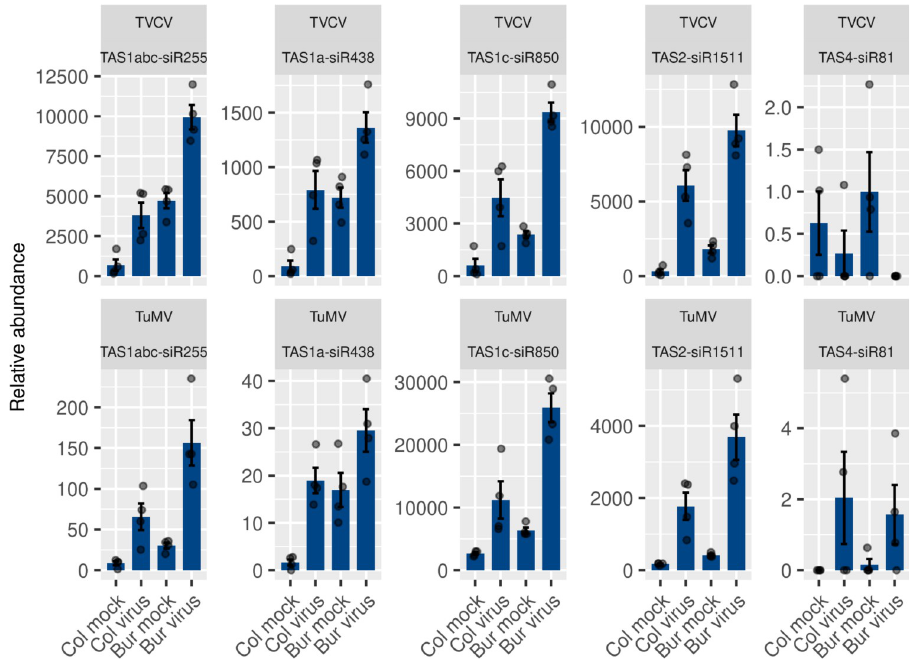
Fig 12. Expression pattern of functional tasiRNAs other than the TAS3 -derived tasiARF. The normalized expression values of the functional siRNAs are shown in the TVCV and TuMV series. We considered only the mature, functional sequence; other sequence variants or non-functional siRNAs from the same TAS locus were not included in the analysis. Error bars represent the standard error of the mean of four biological replicates. The actual data points are also